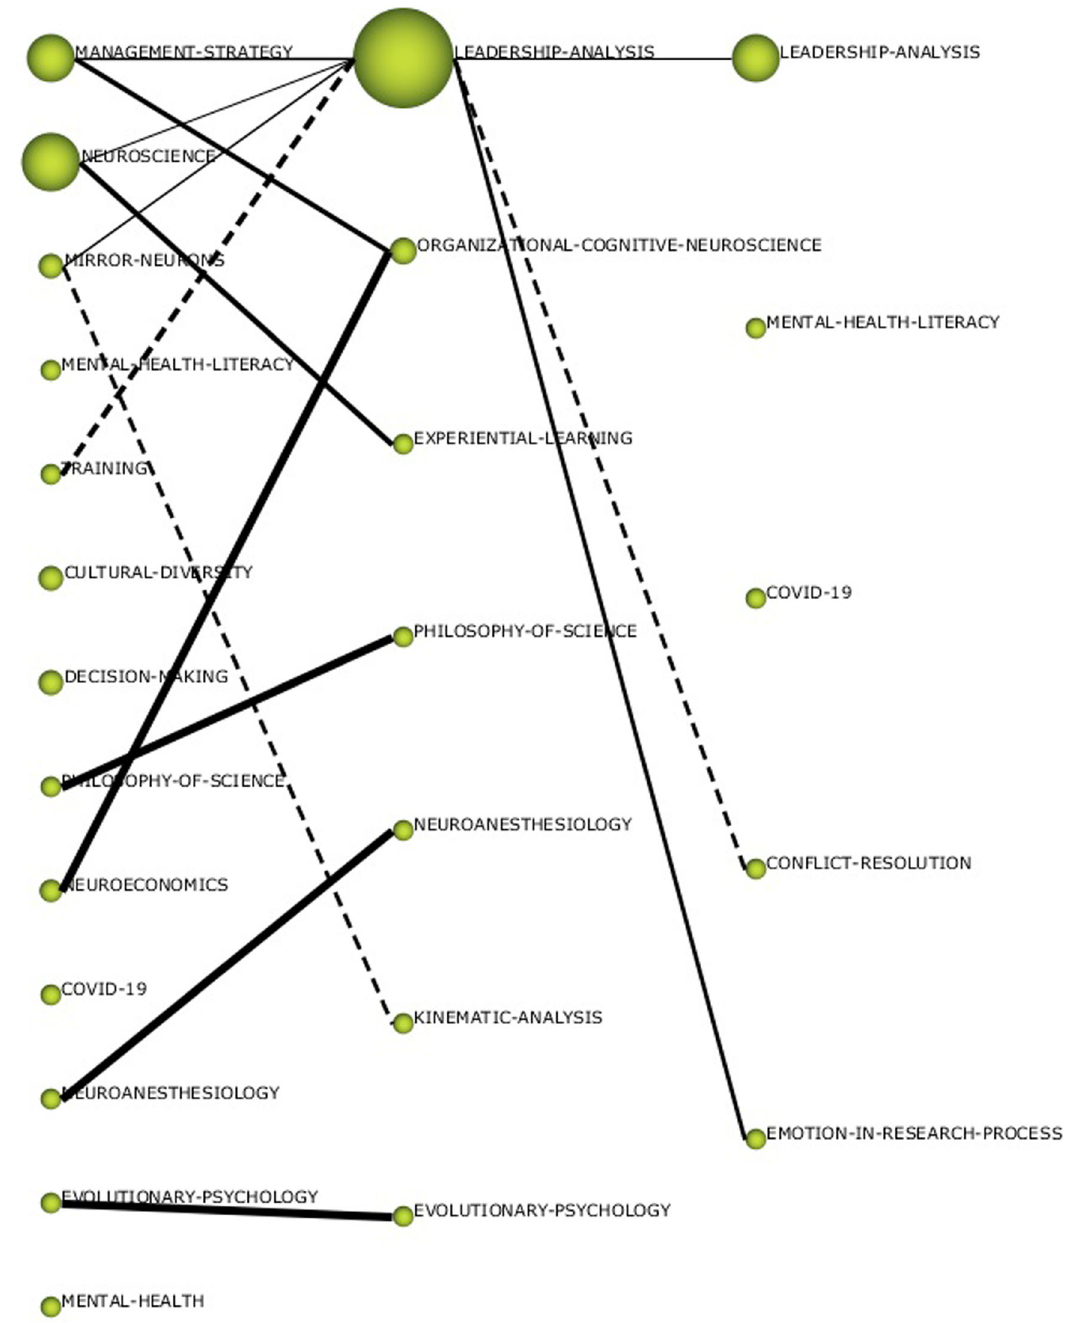
Fig. 4 Thematic evolution of the research fi eld (number of documents). Results from SciMat. The fi rst fi gure is for all period (1992 – 2022), the second for pre-pandemic (1992 – 2019) and the last one for pandemic (2020 –